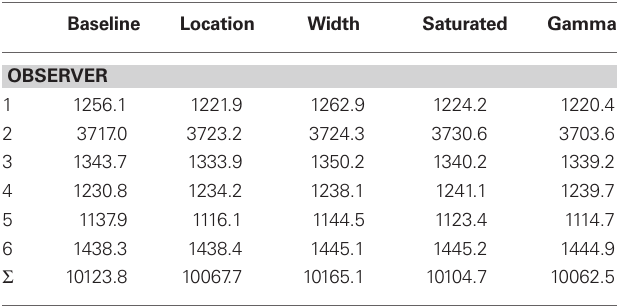
Table 1 | Bayesian information Criterions (and summed BiCs) for all six observers for each of the four gaussian comparison